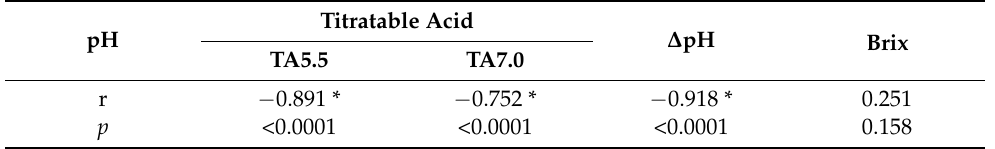
Table 3. Correlation (r values) between the pH and dental erosion values from liquid analgesics and